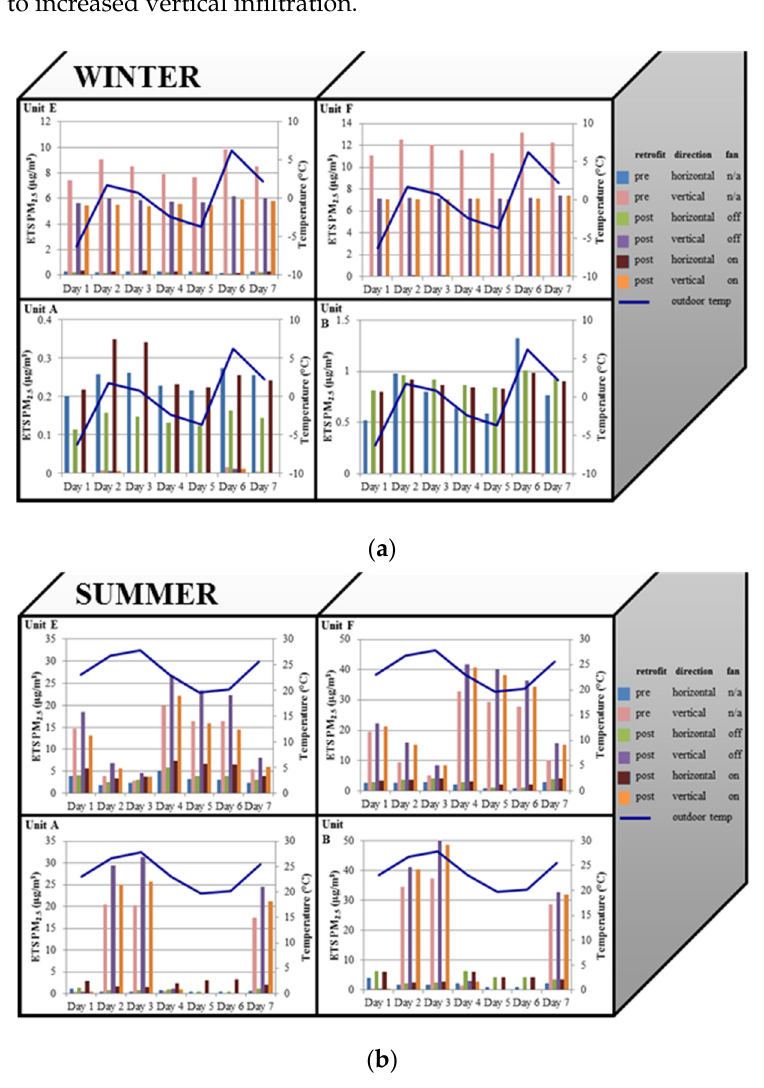
Figure 4. Predicted daily average ETS PM 2.5 infiltration in A, B, E and F units from all other apartments during ( a ) the winter; and ( b ) the summer, over a week, compared to average daily outdoor temperature. Building is 2 townhouse units high and 4 units across, and only half the building is shown in the figure. A and E are end units, and B and F are interior units adjacent to units A and E. Note different maximum in y-axis scales.